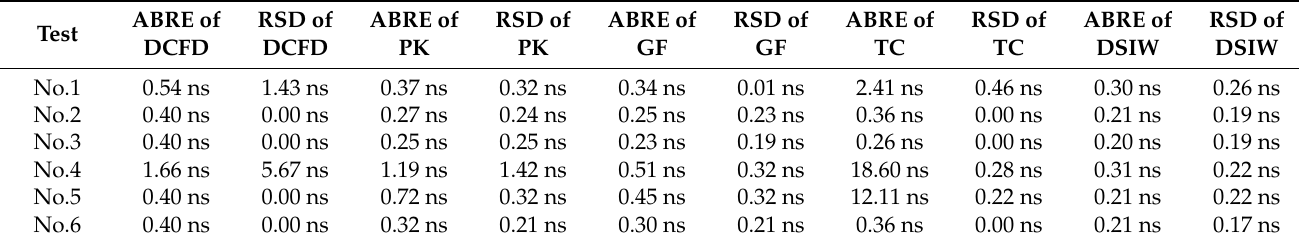
Table 2. Average absolute ranging error and ranging standard